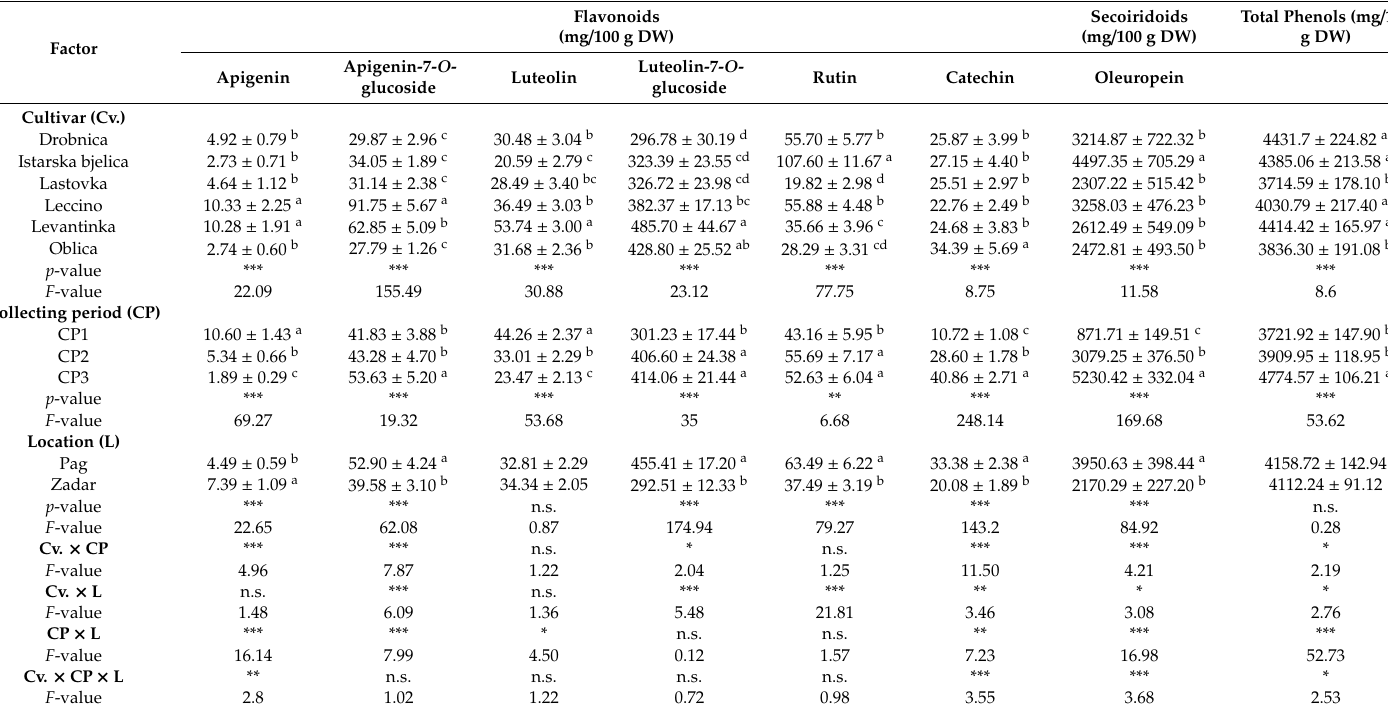
Results are expressed as means ± standard errors. Di ff erent superscript lowercase letters in a column represent statistically significant di ff erences between mean values for each main e ff ect at p < 0.05 obtained by a two-way ANOVA and Tukey’s test. First (Cv. × CP, Cv. × L, CP × L) and second order interactions (Cv. × CP × L) are presented. Significance: ***— p <